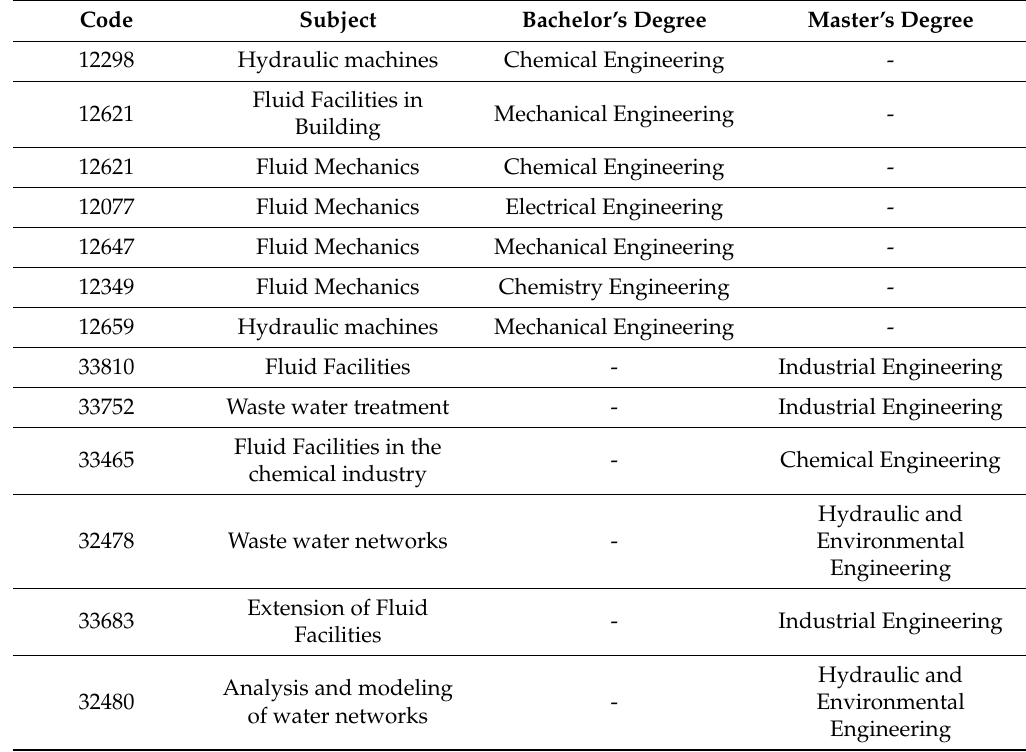
Table 2. Subjects of the teaching project.